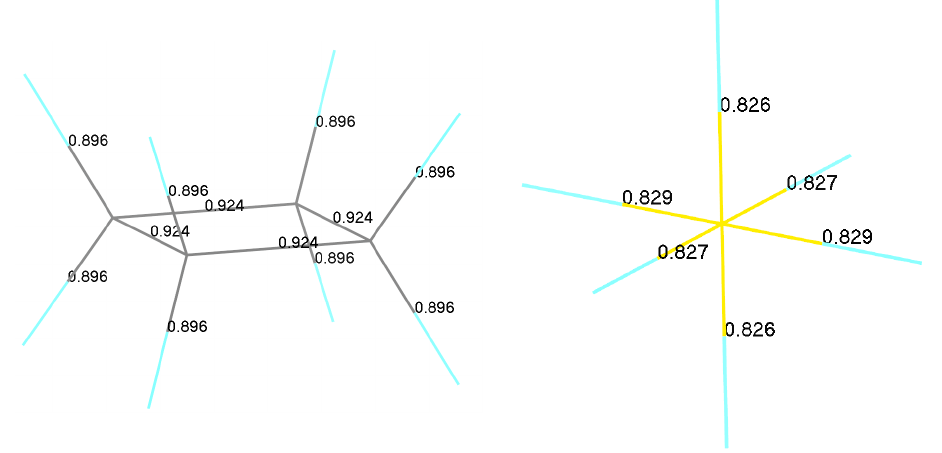
Figure 7. c-C 4 F 8 and SF 6 bond-level distribution.